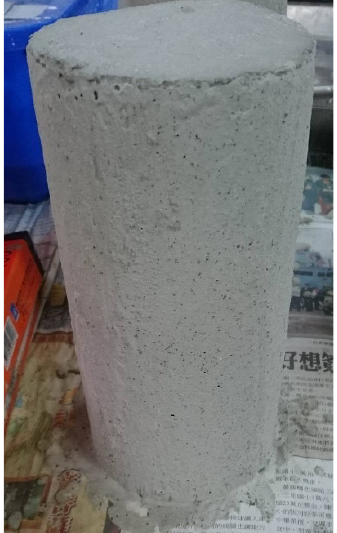
Figure 1. Schematic diagram of specimen sealing method. Table 3. Description of the adopted inorganic crystalline materials.